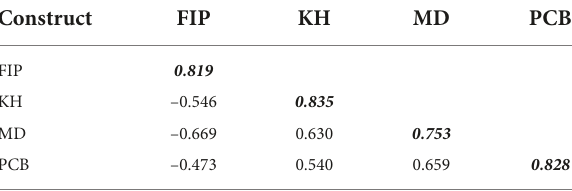
TABLE 3 Discriminant validity (HTMT)